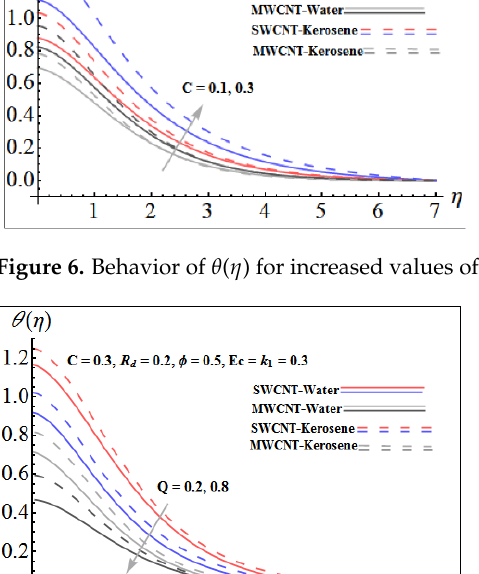
Figure 7. Behavior of θ ( η ) for increased values of Q .